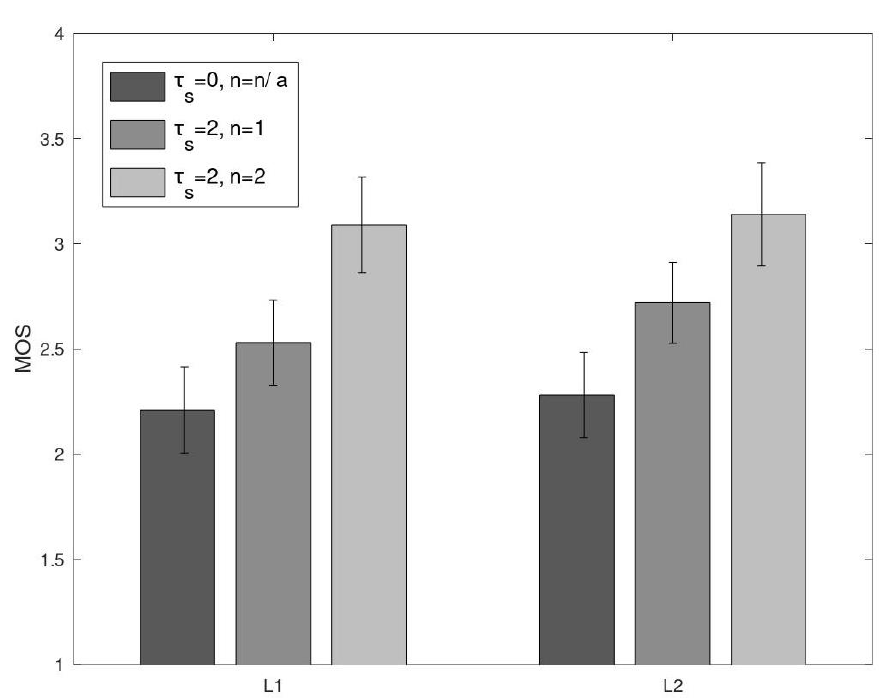
Figure 6. MOS with 95% confidence intervals of the “Foreman” video with two outage locations for τ j = 2 and τ o =